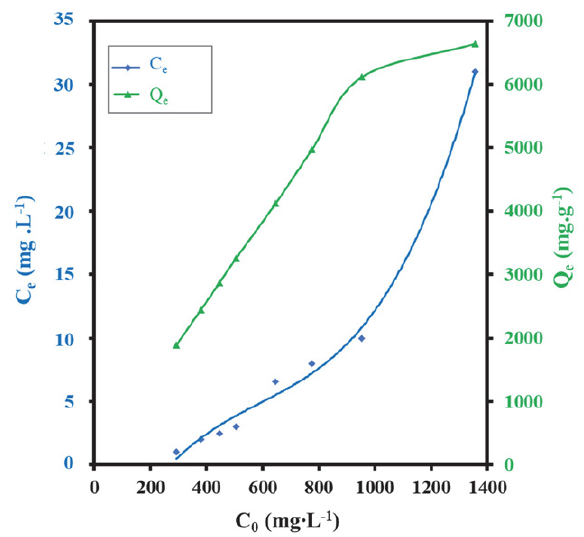
Figure 3. Equilibrium concentration (C e ) and adsorption capacity (Q e ) versus the initial concentration (C 0 ) for nickel removing at 9.8 mA cm –2 , 60 °C and pH 8.6.